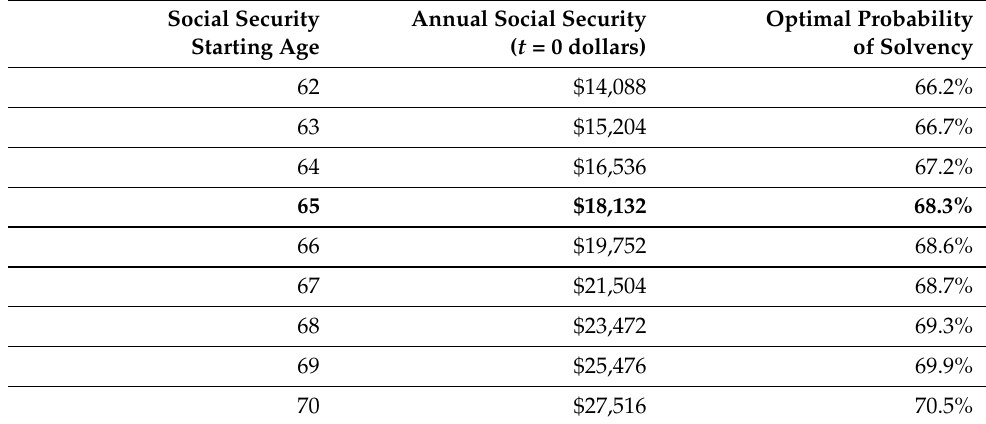
Table 16. The effect on Investor #1 of varying the start of collecting Social Security from its normal age (in